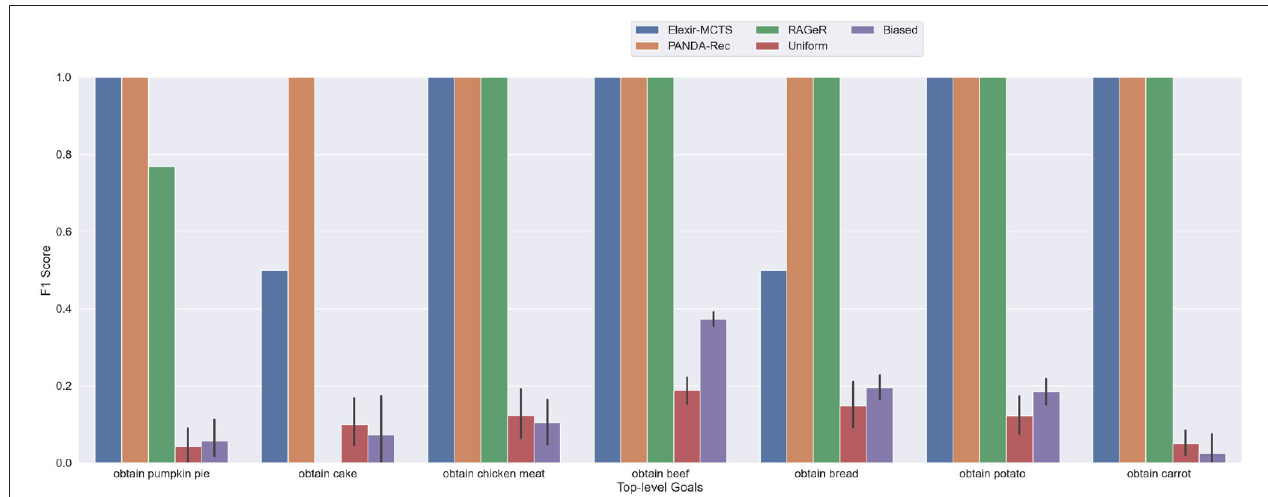
FIGURE 5 | Performance of PANDA-Rec, Elexir-MCTS, RAGeR, and two baselines (Random Uniform and Random Biased Recognition) over the high-inspectability Minecraft traces . Metric shown in the figure is the F1 score for each top-level goal in the Minecraft domain. Random Uniform and Random Biased bars are calculated for each top-level goal by taking the average F1 score over 10 runs.